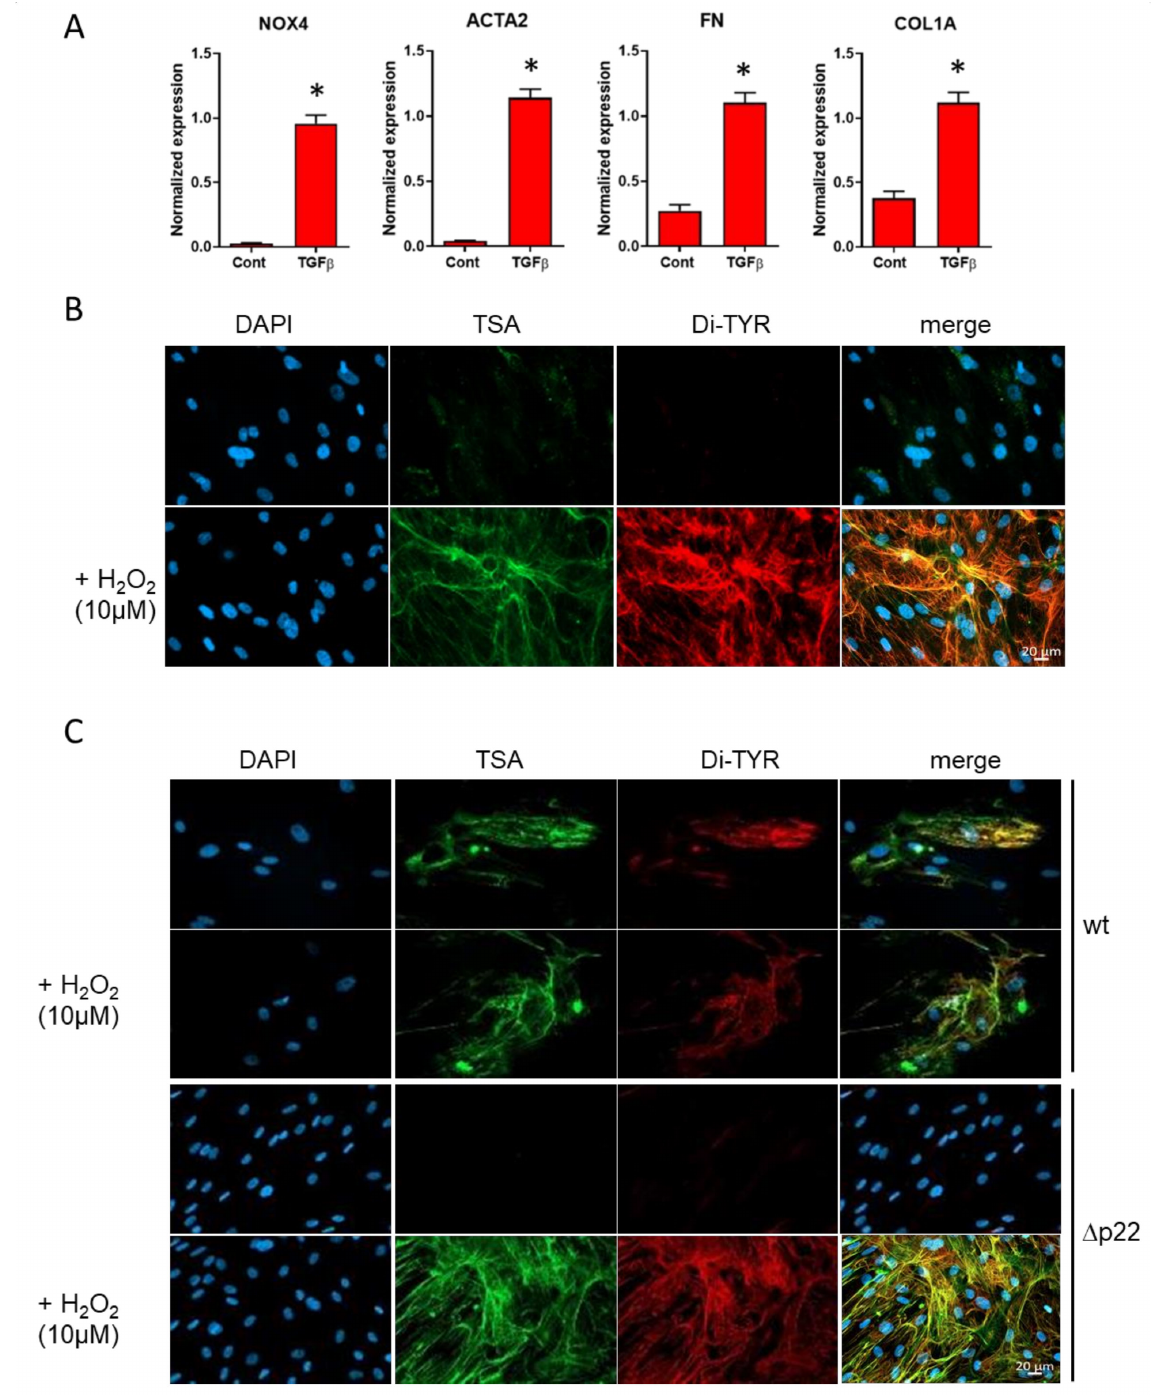
Figure 1. ( A ) TGF β 1-induced upregulation of the expression of NOX4 , the myofibroblast marker alpha-SMA and proteins of the ECM in MRC5 human lung fibroblasts. N = 4, * p < 0.05 using Mann − Whitney nonparametric test. ( B ). Fluorescent microscopy of DT in TGF- β 1-treated MRC5. Addition of H 2 O 2 in presence of HRP cells induces crosslinking of the fluorescein tyramide (TSA, green) with the extracellular matrix network. The cross-links are detected by the DT antibody (red) and colocalize with crosslinked TSA (yellow). ( C ). Similar experiment with human skin fibroblasts from a healthy donor and a patient carrying a p22 phox mutation. Deletion of p22 phox completely abolishes the formation of DT in the absence of exogenous H 2 O 2 . Blue, DAPI staining of cell nuclei. NOX4 : NADPH oxidase isoform 4; ACTA 2: Actin Alpha2, Smooth Muscle; FN: Fibronectin; COL1A: Collagen1A; DAPI: 4 (cid:48) ,6-diamidino-2-phenylindole; TSA: Alexa Fluor 488 tyramide Reagent; Di-TYR: dityrosine; TGF β : Transforming growth factor β ; Cont: control; HRP: horseradish